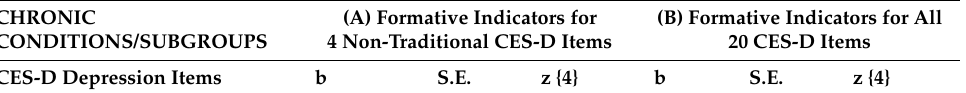
Table 2. Depression in Diabetes and Heart Failure and as Comorbid Conditions in Targeted, Synergis- tic Subgroups: Full or Sequential MIMIC Models with Formative Indicators as Exogenous Predictors or Illness Context Mediators {1, 2, 3}